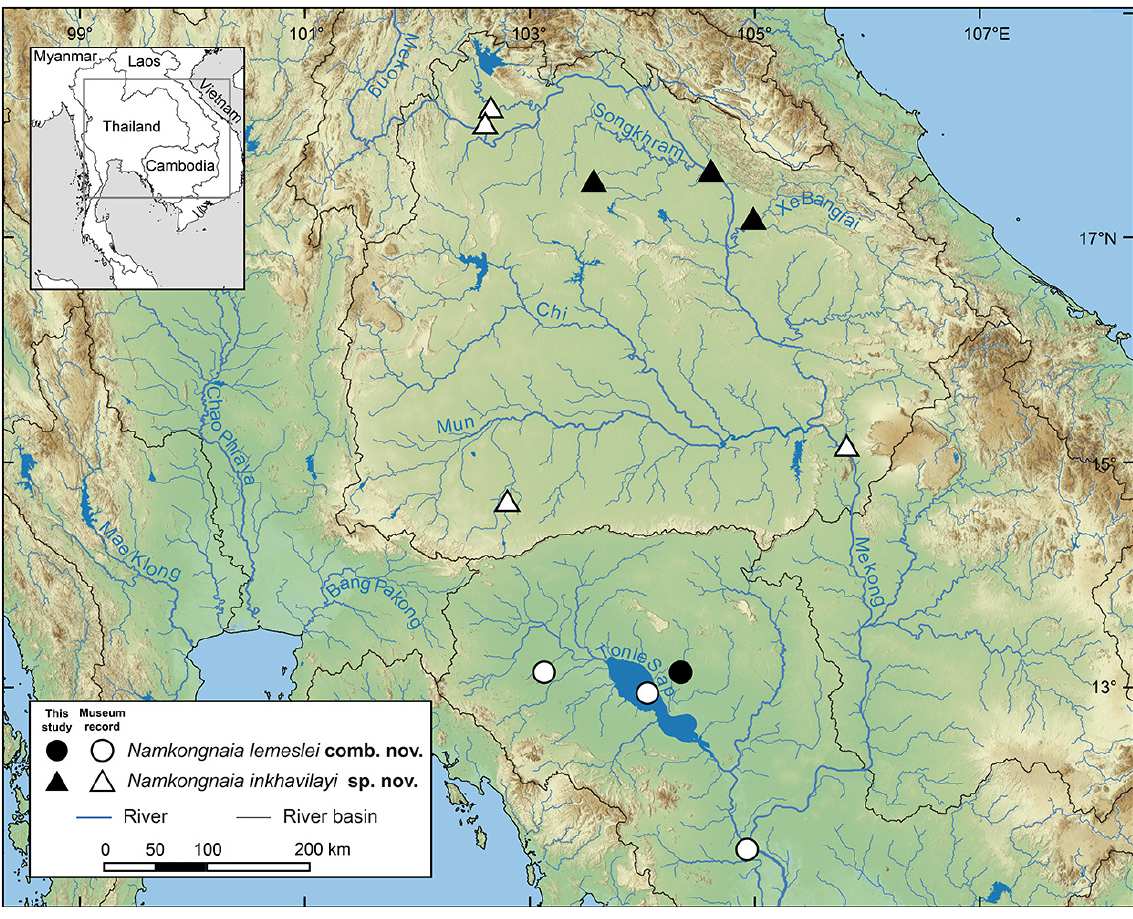
Fig. 3. Map showing distribution localities of Namkongnaia gen. nov. Boundaries of river basins follow Abell et al.